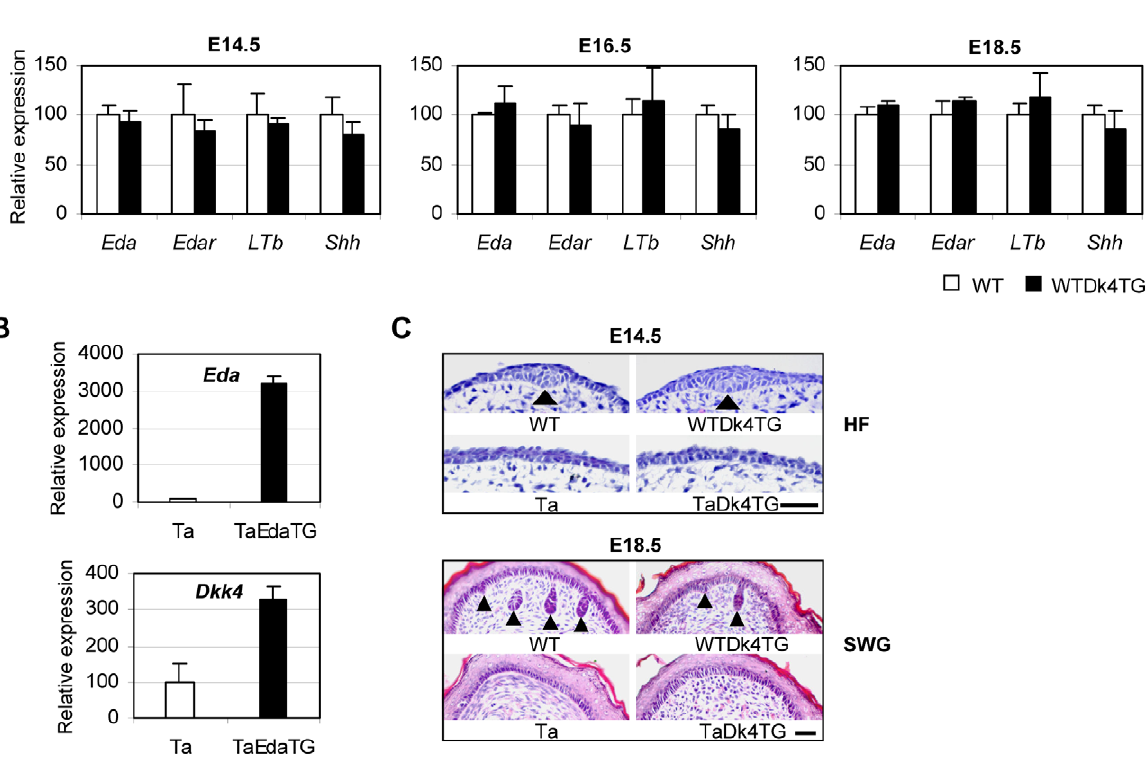
Figure 5. EDA pathway genes were not affected in Dkk4 transgenic mice, and the Dkk4 transgene did not rescue Ta phenotypes. A, Q- PCR assays showed that expression levels of Eda, Edar, LTb and Shh were not changed in WTDk4TG skin at E14.5, 16.5 and 18.5. B, Expression levels of Eda (upper panel) and Dkk4 (lower panel) were upregulated in Eda-A1 transgenic Tabby mice (TaEdaTG) at E16.5. C, Primary hair germs were normally formed in WT and WTDk4TG mice, but not in Ta or TaDk4TG mice, at E14.5 (upper panels). Similarly, sweat gland pegs were normally formed in WT and WTDk4TG mice, but not in Ta or TaDk4TG mice at E18.5 (lower panels). Scale bars, 400 m m.